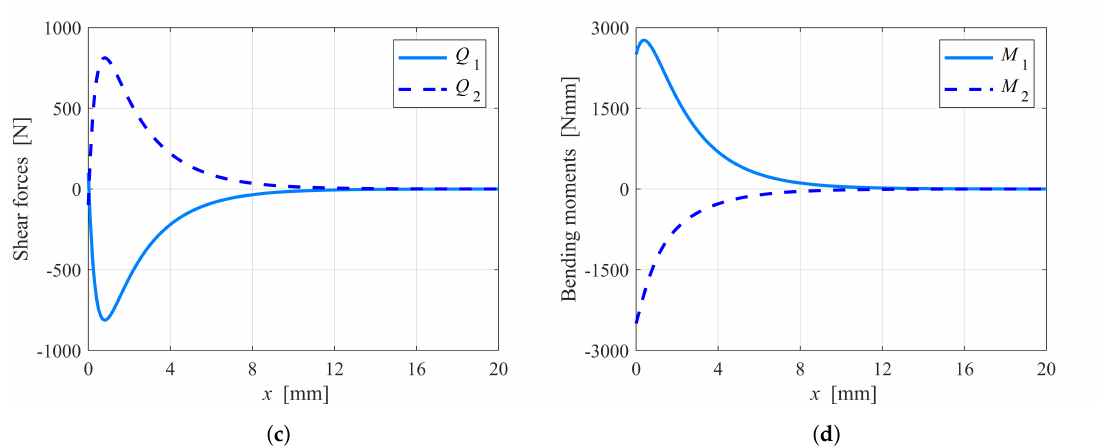
Figure 6. UD//MD specimen: ( a ) interfacial stresses, ( b ) axial forces, ( c ) shear forces, and ( d ) bending moments in the crack tip neighborhood.